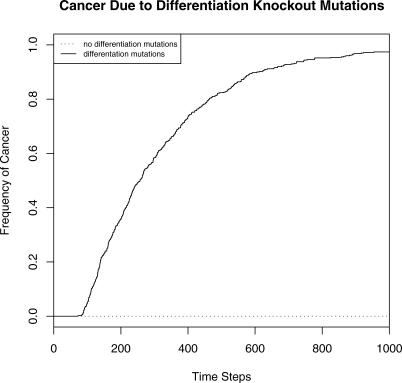
Kaplan-Meier Curves for the Time Until Exponential Cell Growth (Cancer) Were Detected Due to a Spontaneous Differentiation Knockout MutationThe solid line represents 500 trials during which differentiation loss-of-function mutations occurred at a rate of 10−4 per cell division. The dotted line represents the Kaplan-Meier curve for 500 trials in which no differentiation mutations were allowed. A differentiation knockout mutation can cause exponential cell population growth in any nonterminal differentiation stage driven by the feedback loops that normally maintain tissue homeostasis.